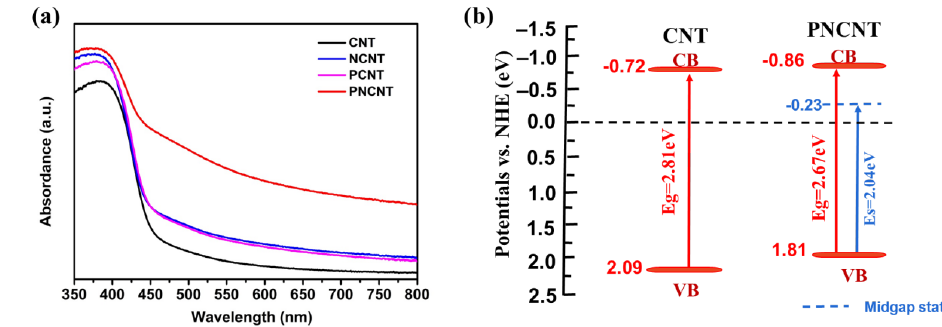
Figure 7. UV-vis diffuse reflection spectra of CNT, NCNT, PCNT and PNCNT samples ( a ) and the band structure of CNT and PNCNT samples ( b ).